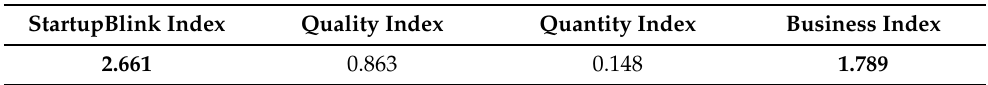
Table 2. Resolution ratio values for the global StartupBlink index and its constituents. In bold, R values greater than